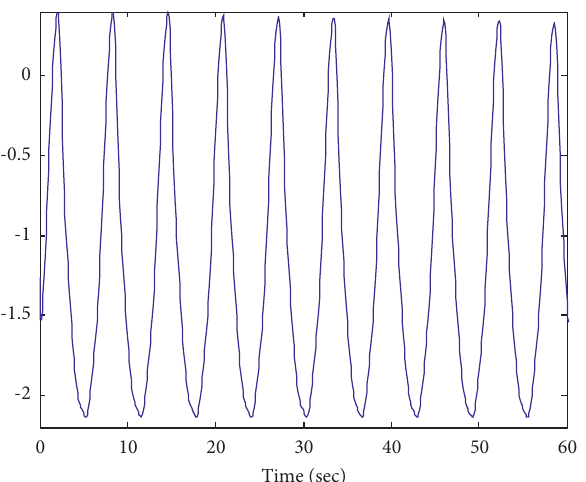
and Y . 1 1 ,r Figure 10: Trajectories of tracking errors between Y